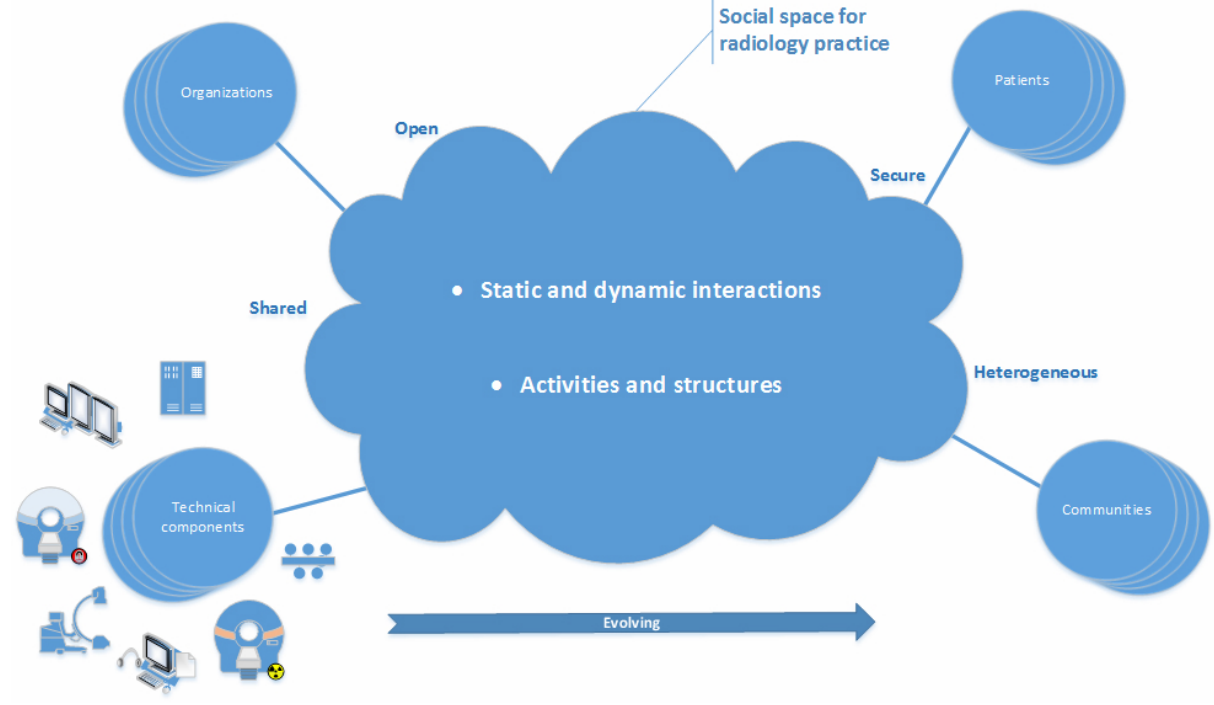
Figure 2. Social radiology as an information